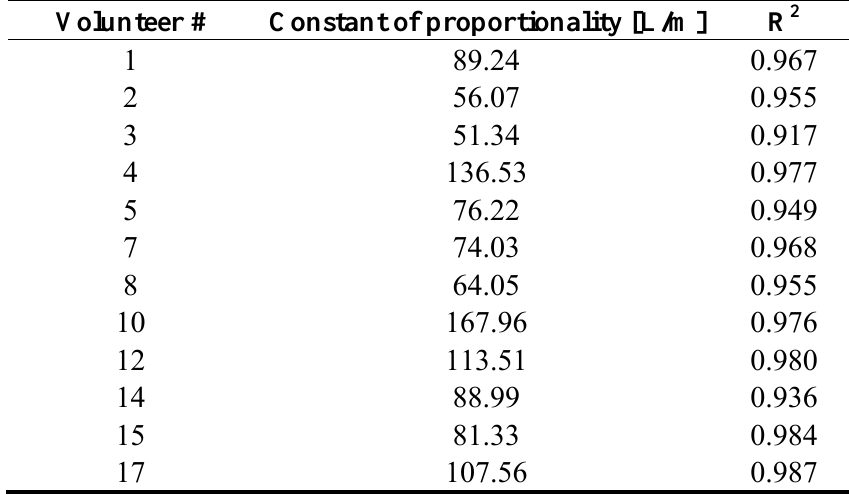
Table 3. Constant of proportionality and coefficient of determination for every volunteer.